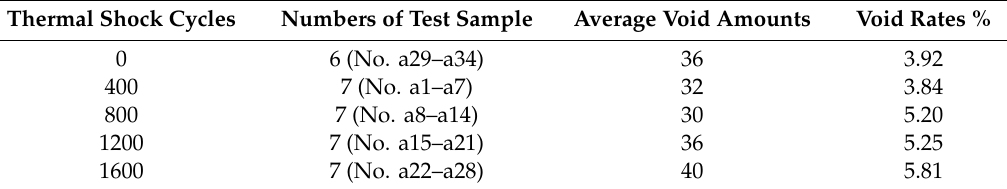
Table 4. The measured void information in the solder joint.